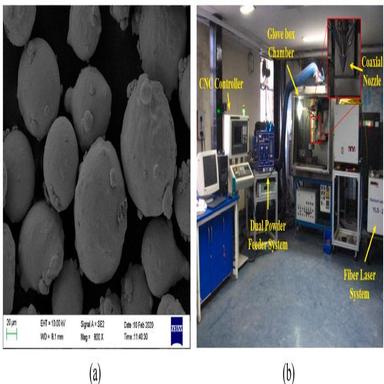
LDED of Cu (a) Powder Morphology (b) Experimental setup.